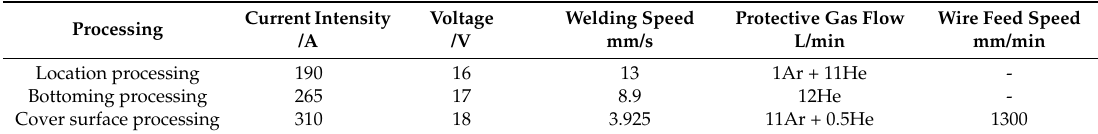
Table 2. Parameters of the welding